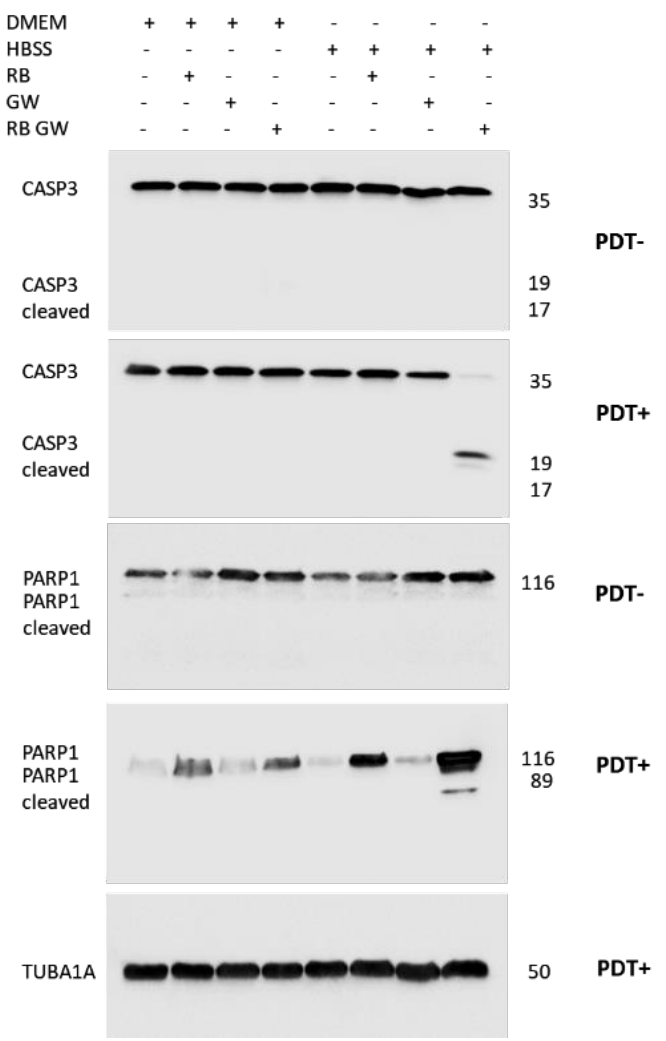
Figure 14. Expression of apoptotic markers in T98G cells following RB starvation, PDT exposition and GW4869 administration scheme. Caspase 3 (CASP3, revealed by anti-Caspase 3 antibody, Cell Signaling, #9662), PARP1 (Cell Signaling, #9532) and α -tubulin (TUBA1A, Cell Signaling, #2144) proteins expression in untreated standard growing (DMEM) or HBSS starvation, with/without RB (0.75 μ M), GW4869 (GW = 5 μ M), PDT stimulation (2 min at 562/576 nm), after additional 24 h p.t. in standard growing conditions. For each sample, 40 µ g of total protein extracts was loaded into 12% polyacrylamide gels. All the experiments were performed in duplicates with independent assays. A representative experiment is shown. Molecular weights in KDa are reported.